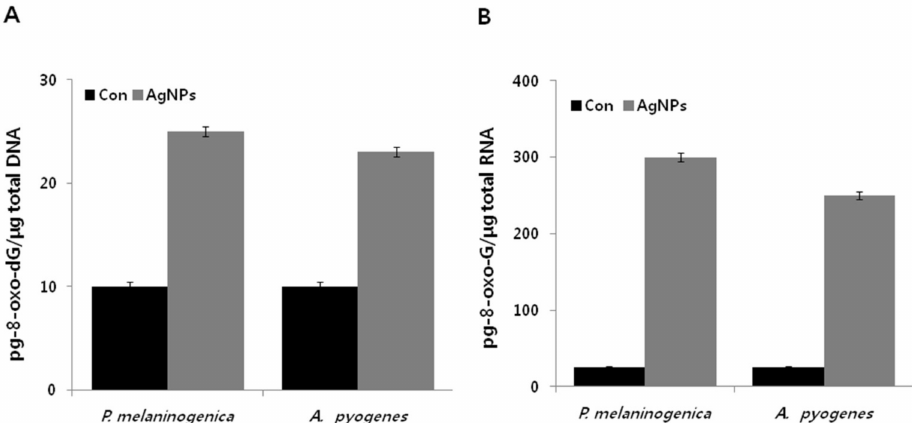
Figure 8. Measurement of DNA/RNA oxidation. P. melaninogenica and A. pyogenes cells were treated with 0.8 and 1.0 µ g/mL of AgNPs respectively for 12 h, and oxidation of ( A ) DNA was measured by 8-oxo-dG levels and ( B ) oxidation of RNA was measured by 8-oxo-G